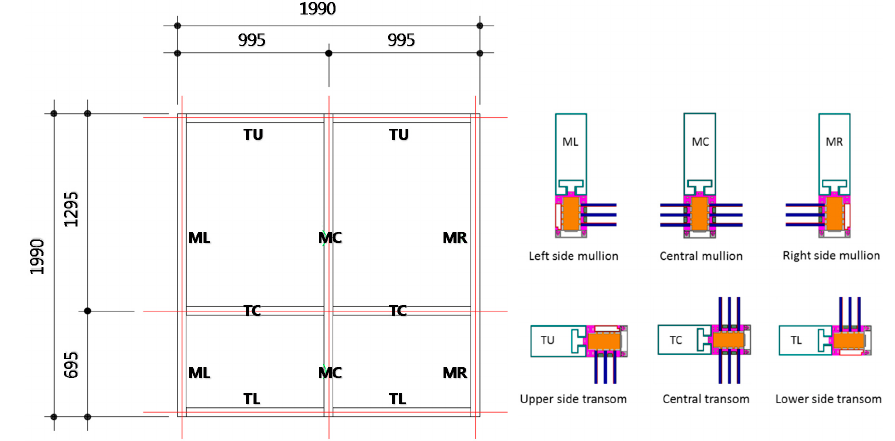
Figure 2. Size of a test specimen and the cross-sections of the frame. Table 3. Thermal conductivities of materials used in the simulation.